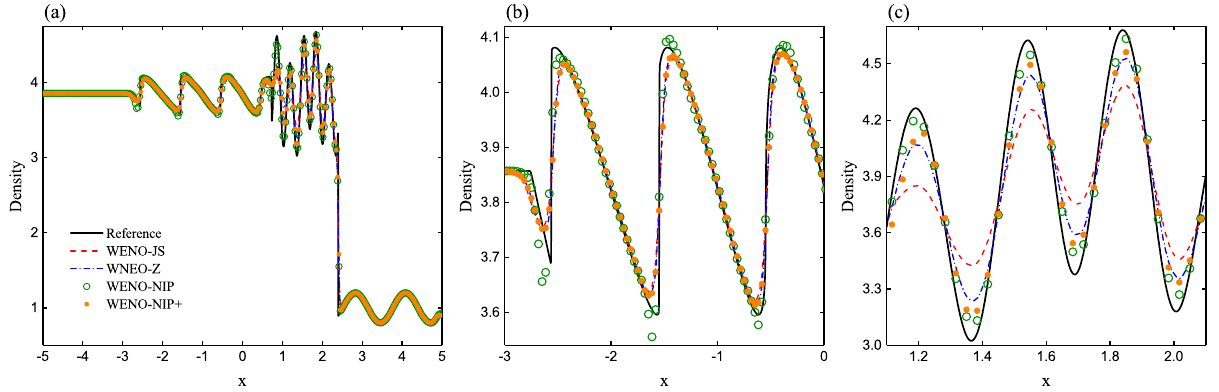
Figure 17. ( a ) Numerical solutions of the shock-density wave interaction of Shu and Osher calculated by WENO-JS, WENO-Z, WENO-NIP, and WENO-NIP+ at t = 1.8 with N = 300. ( b ) Zoom in near the region behind the high-frequency waves. ( c ) Zoom in near the high-frequency